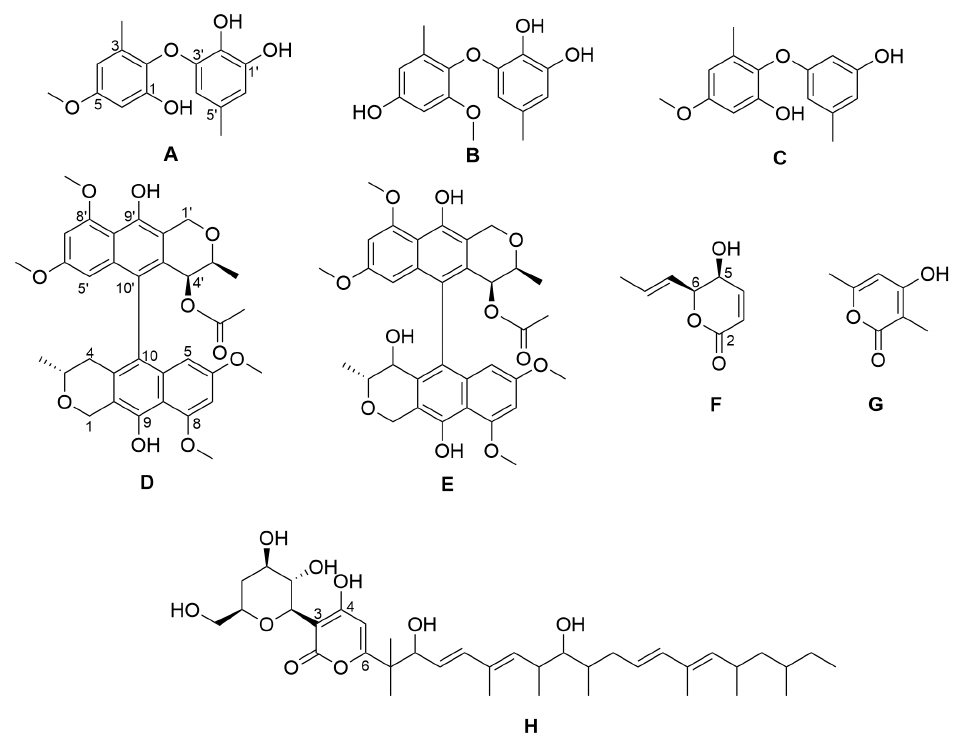
Figure 1. Chemical structures of the isolated compounds. NK-A 17e233 ( A ); 1,2-benzenediol, 3-(4- hydroxy-2-methoxy-6-methylphenoxy)-5-methyl-(ACI) ( B ); cyperin ( C ); ES-242-1 ( D ); ES-242-3 ( E ); 5 S ,6 S -phomalactone ( F ); methyltriaceticlactone ( G ); S 39163/F-1 ( H ).